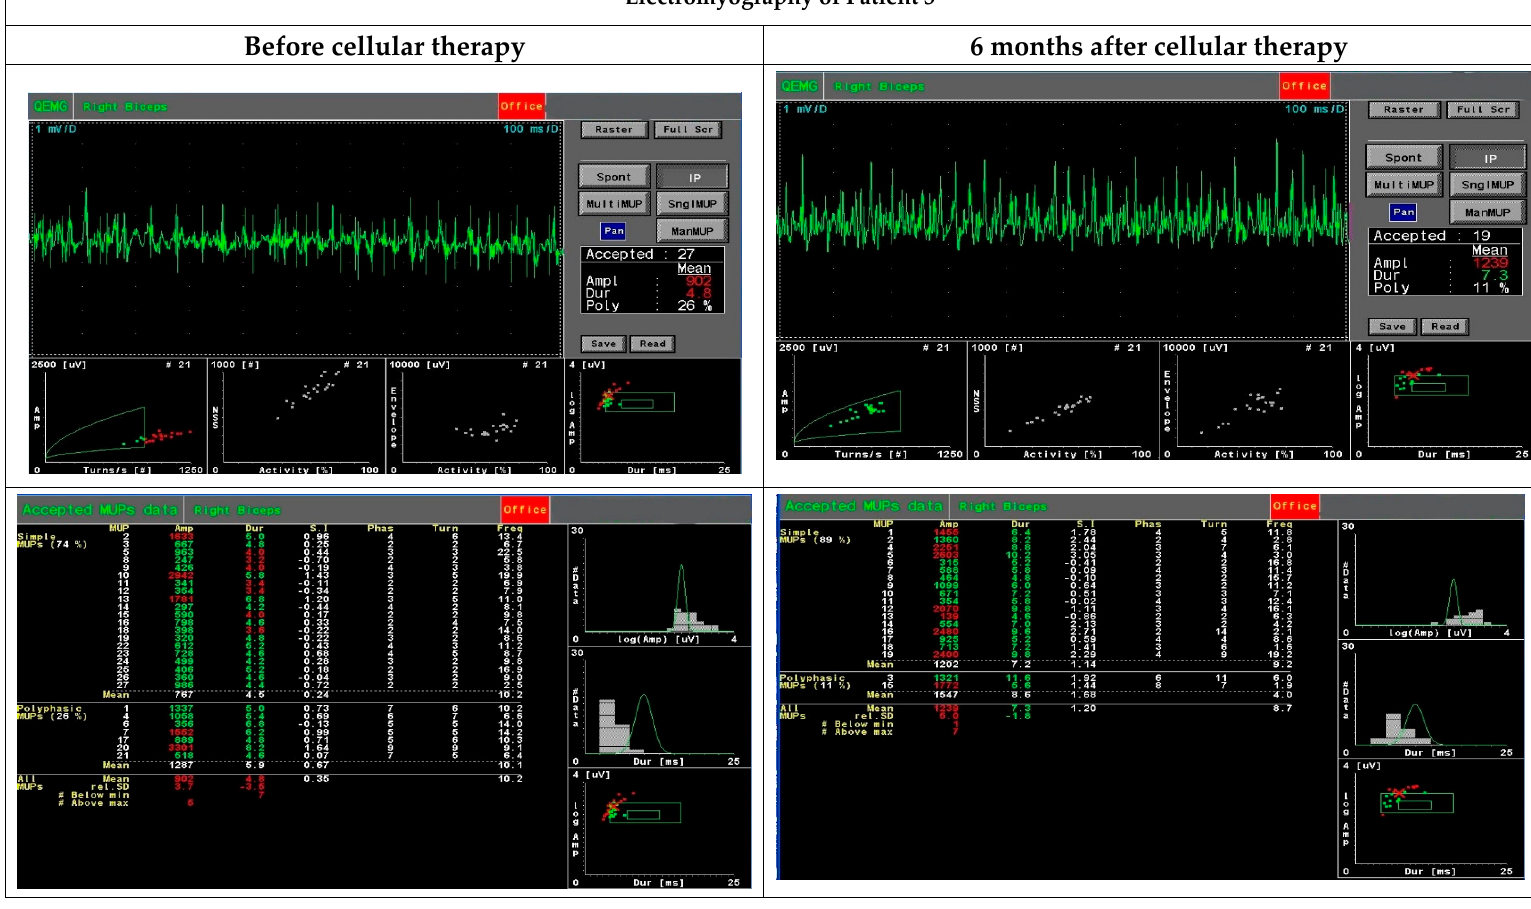
Figure 3. Functional assessment performed with electromyography before and six months after cellular therapy in Patient 3 revealed an increase in motor unit parameters, especially duration, amplitude range, area and size index.